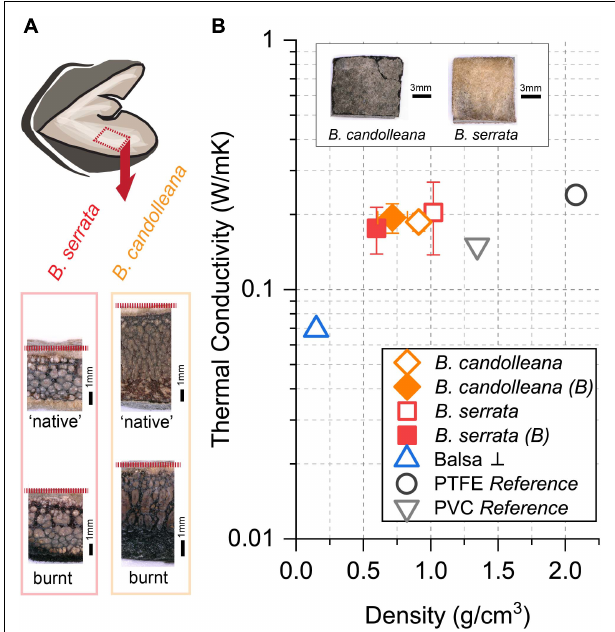
FIGURE 5 | Thermal conductivity of follicle valves in comparison to reference materials. (A) Position of samples and transverse view of ‘native’ (non-burnt) and burnt samples, showing the layered tissue structure and sample thickness (dashed red line indicates the location of the endocarp/innermost valve tissue). (B) Thermal conductivity at ∼ 43 ◦ C for non-burnt and burnt (B) valve samples of B. candolleana (mean ± SD, n = 3) and B. serrata (mean ± SD, n = 3) compared to other materials as a function of density. The outer surfaces of exemplary valve samples are shown on the images (non-burnt). Moisture content MC ≈ 8% for non-burnt follicles, flame exposure of the follicle surface for t = 30 s for burnt samples. Values of PTFE and PVC are taken from reference and samples were used for set-up calibration. Commercial Balsa wood ( MC ≈ 5%, n = 1) was measured perpendicular ⊥ to the grain and used as a standard to test the accuracy of our simple